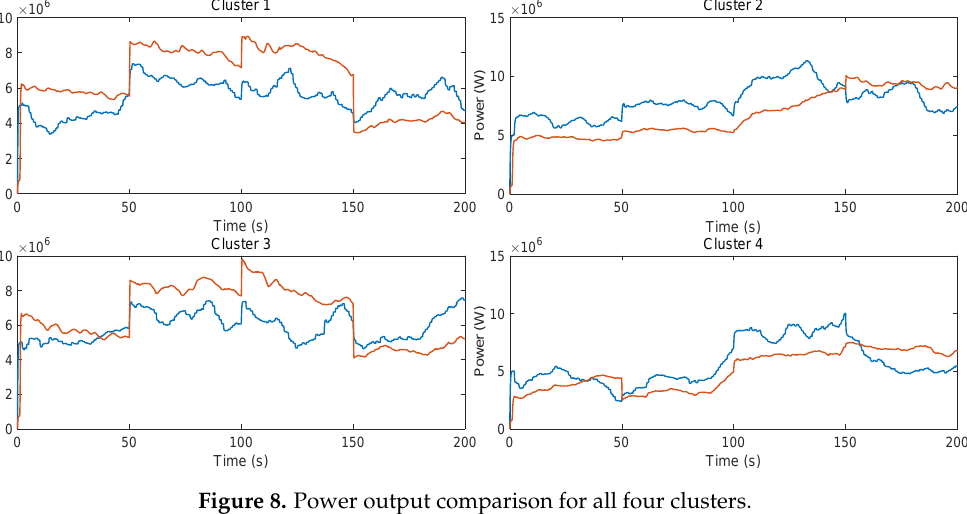
Figure 8. Power output comparison for all four clusters.